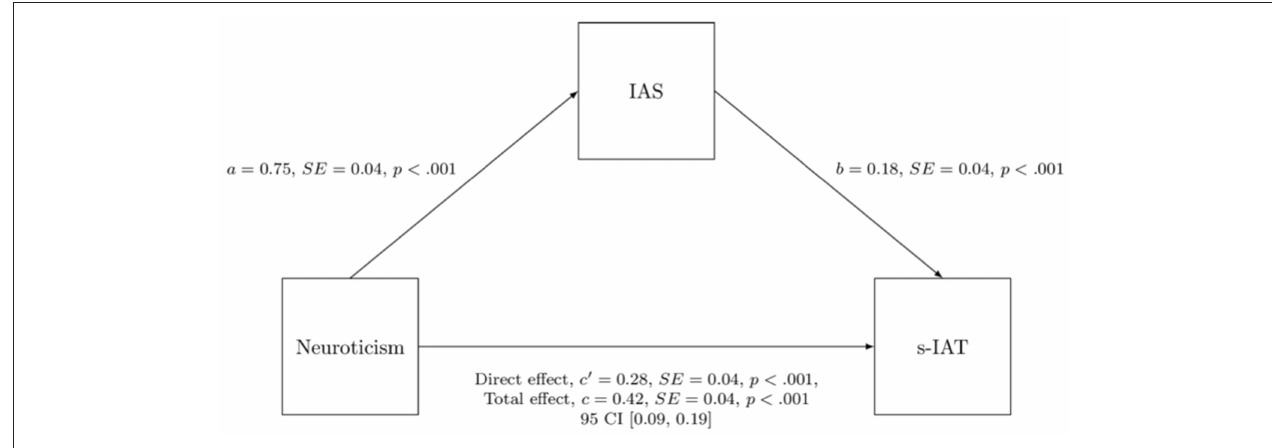
FIGURE 2 | IAS functions as a mediator between Neuroticism and s-IAT.